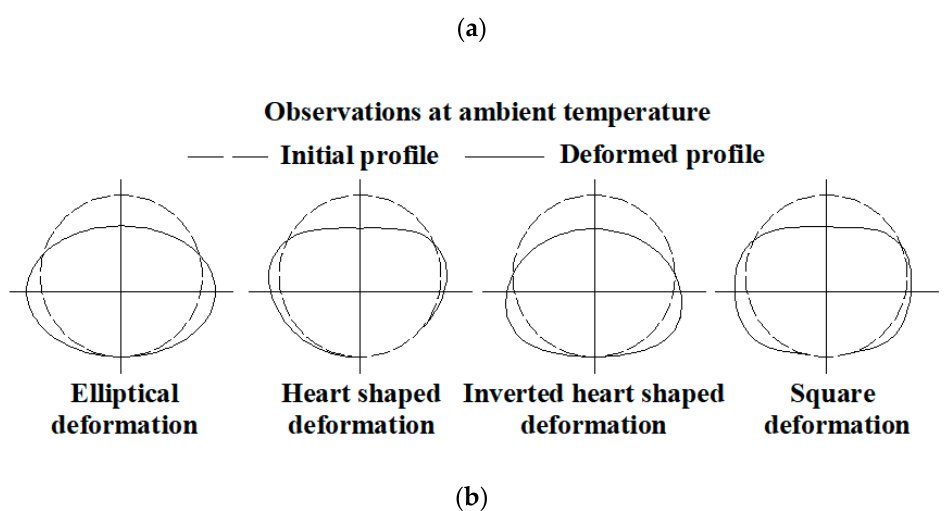
Figure 4. The pipe deformation profile: ( a ) measured in this paper (200 kPa); ( b ) types of deformation reported in Howard [17] at ambient temperature.